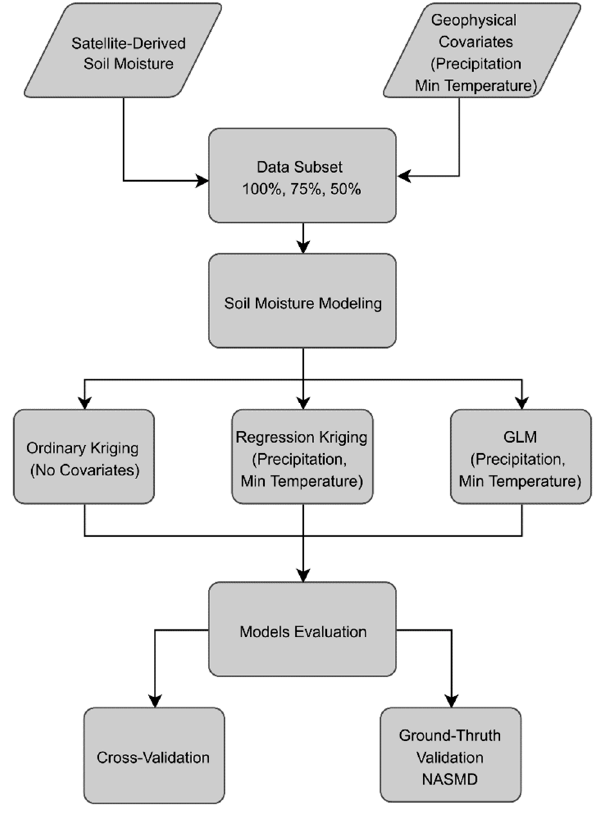
Figure 4. Workflow for soil moisture modeling and the gap-filling over the region of interest, regarding 100%, 75%, and 50% of available valid pixels in each monthly layer. Cross-validation as well as ground-truth validation is also described.